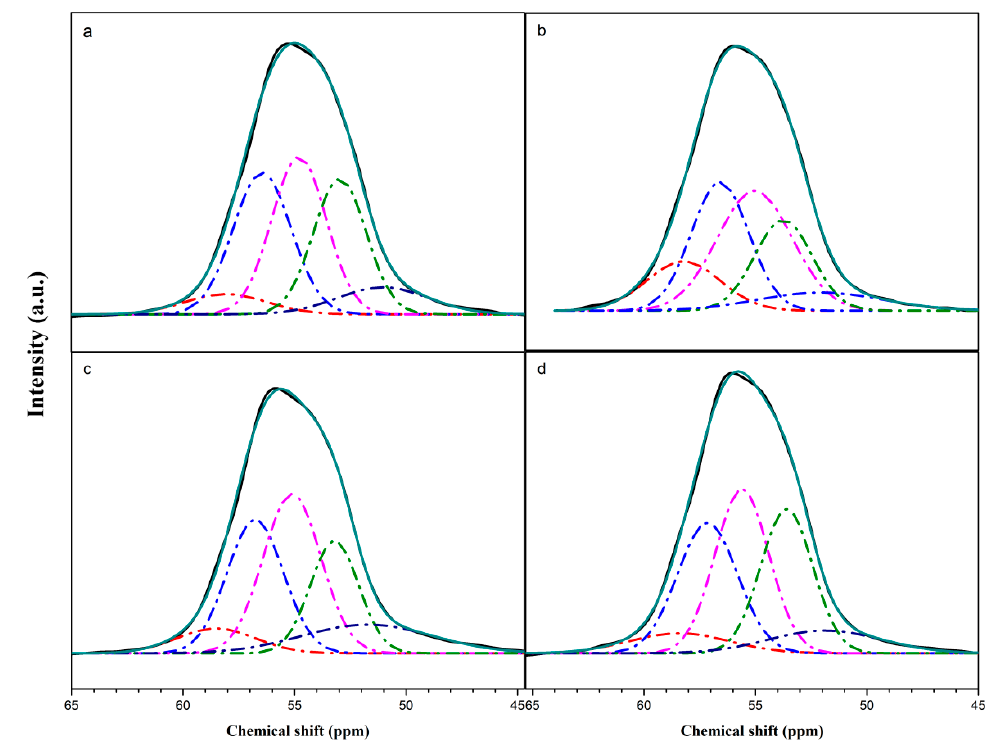
Figure 4. Deconvolution of the 27 Al-MAS NMR spectra of ( a ) HZ(0), ( b ) HZ(0.4), ( c ) HZ(0.8) and ( d ) HZ(1.1) catalysts.